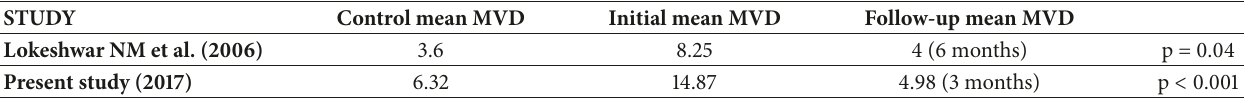
MVD: microvessel